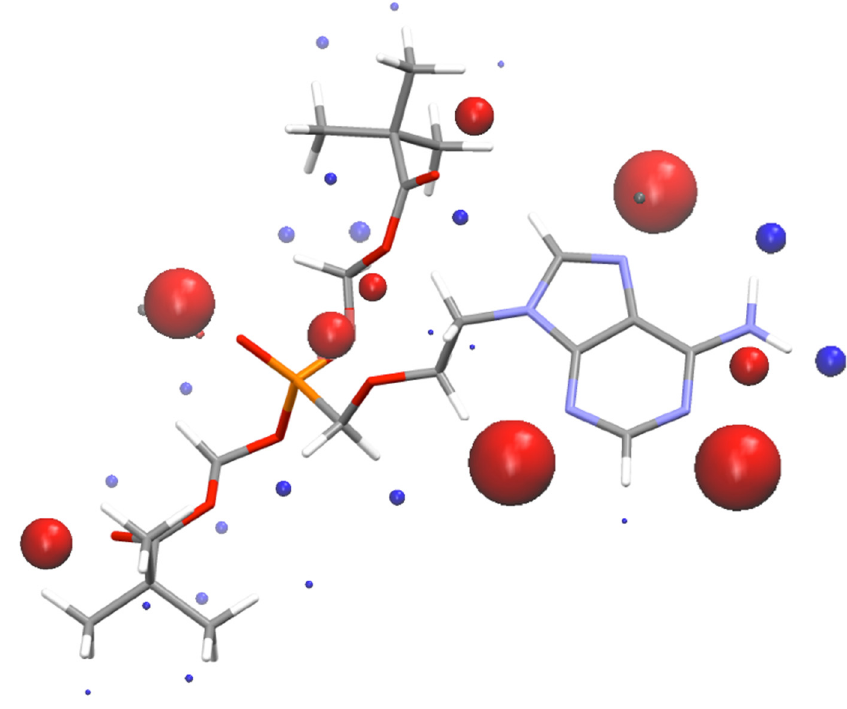
Figure 2. SSIPs calculated for Adefovir Dipivoxyl. Blue spheres correspond to H-bond donors, and red spheres to H-bond acceptors.